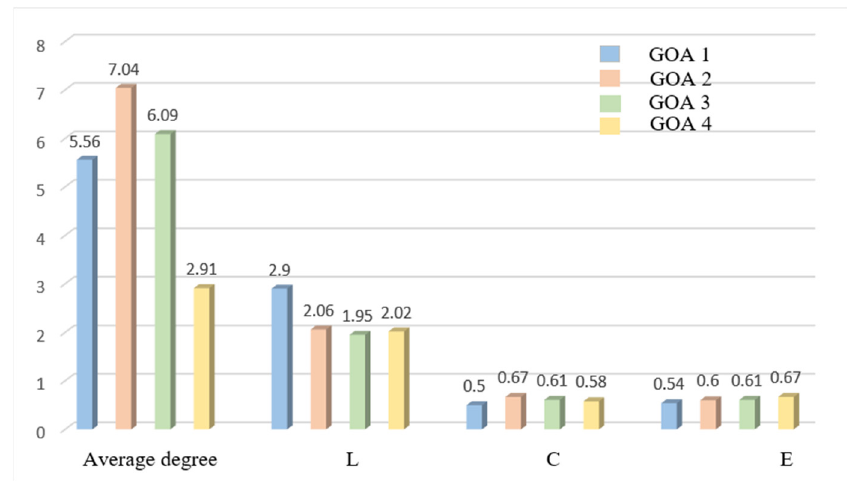
Figure 7. The statistical results of characteristics for shield door fault failures at GOA1–GOA4.